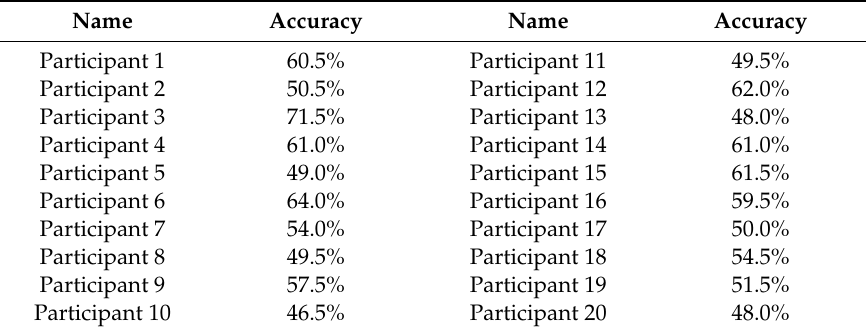
Table 6. The classification accuracy of 20